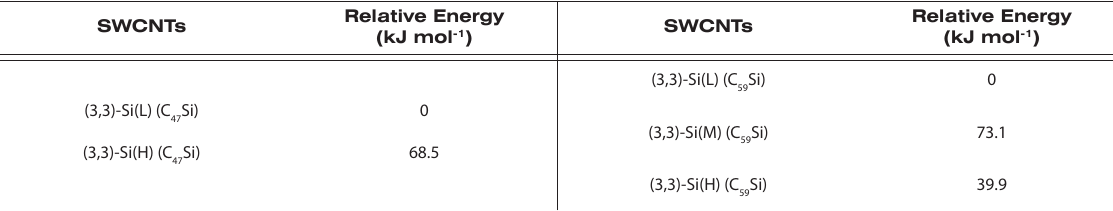
Table 1. Relative energy of doped (3,3) SWCNTs at B3LYP/6-31G(d,p) level